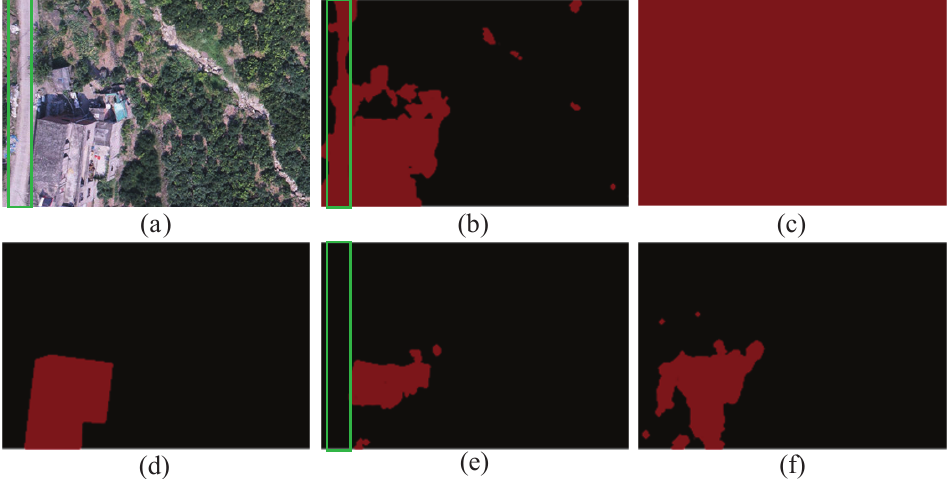
Figure 5. Pseudo-labels obtained with different modules: ( a ) image; ( b ) pseudo-labels with baseline attention module (1000 iterations); ( c ) pseudo-labels with baseline attention module (5000 iterations); ( d ) ground truth; ( e ) pseudo-labels with PAM (1000 iterations); and ( f ) pseudo-labels with PAM (5000 iterations). The green box represents regions of